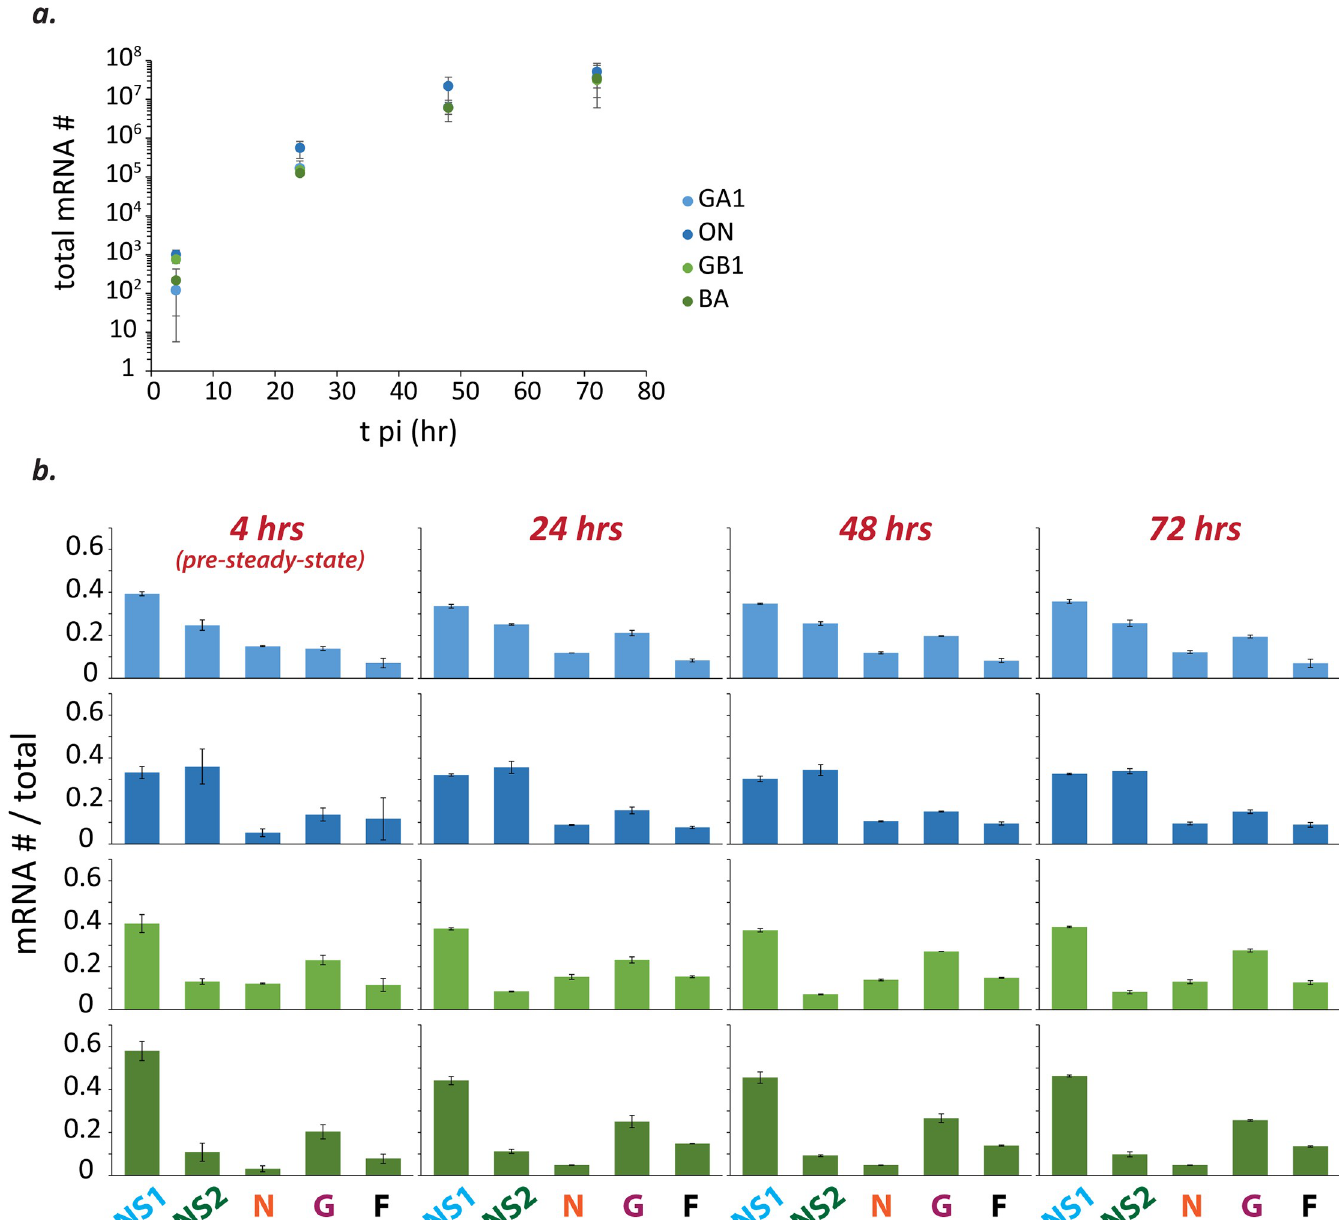
Fig 2. Total mRNA abundances plateau beyond 48 hours post-infection and relative mRNA levels reach steady-state soon after the start of infection. (a) Total mRNA abundances (= NS1+NS2+N+G+F) from HEp-2 cells infected with different isolates of RSV (MOI = 0.01) begin to plateau by ~48 hours post-infection (pi). Each dot (RSV/A/GA1Tracy [pale blue]; RSV/A/ON/121301043A [dark blue]; RSV/B/GB1/18537 [light green]; RSV/B/BA/80171 [dark green]) represents the mean and error bars the standard deviation of two independent experiments (n = 2). For each independent experiment, the mean was calculated from duplicate measurements and used in subsequent calculations. (b) Relative mRNA levels reach steady-state sometime between four and 24 hours pi. Histograms depicting relative mRNA levels are shown for all measured time-points (4, 24, 48, 72 hr pi) and all four isolates (color scheme same as (a)). Each bar depicts the mean mRNA # / total mRNA # of the indicated species and error bars show the standard deviation (n = 2). For each independent experiment, the mean was calculated from duplicate measurements and used in subsequent